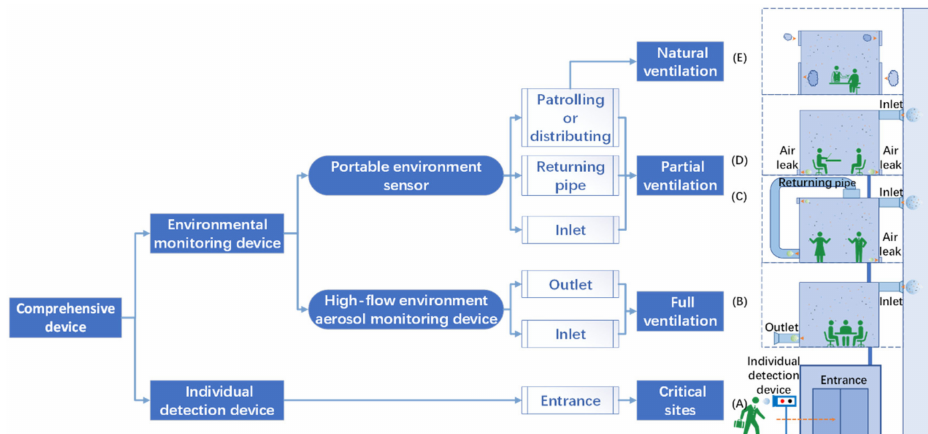
Figure 5. Airborne virus detection strategy for various indoor environments. ( A ) Critical sites in indoor environment; ( B ) Full ventilation environment; ( C ) Partial ventilation with return air; ( D ) Partial ventilation without return air; ( E ) Natural